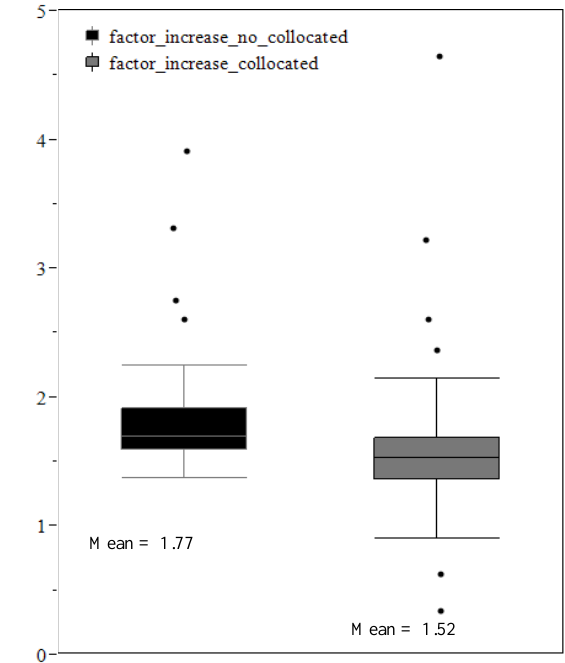
Fig. 6. Factor increase of coverage for MAIAC: non-collocated Figure 6. Factor increase of coverage for MAIAC: non-collocated (black box) and collocated to (black box) and collocated to PM 2 . 5 observations (grey box). PM 2.5 observations (grey box).